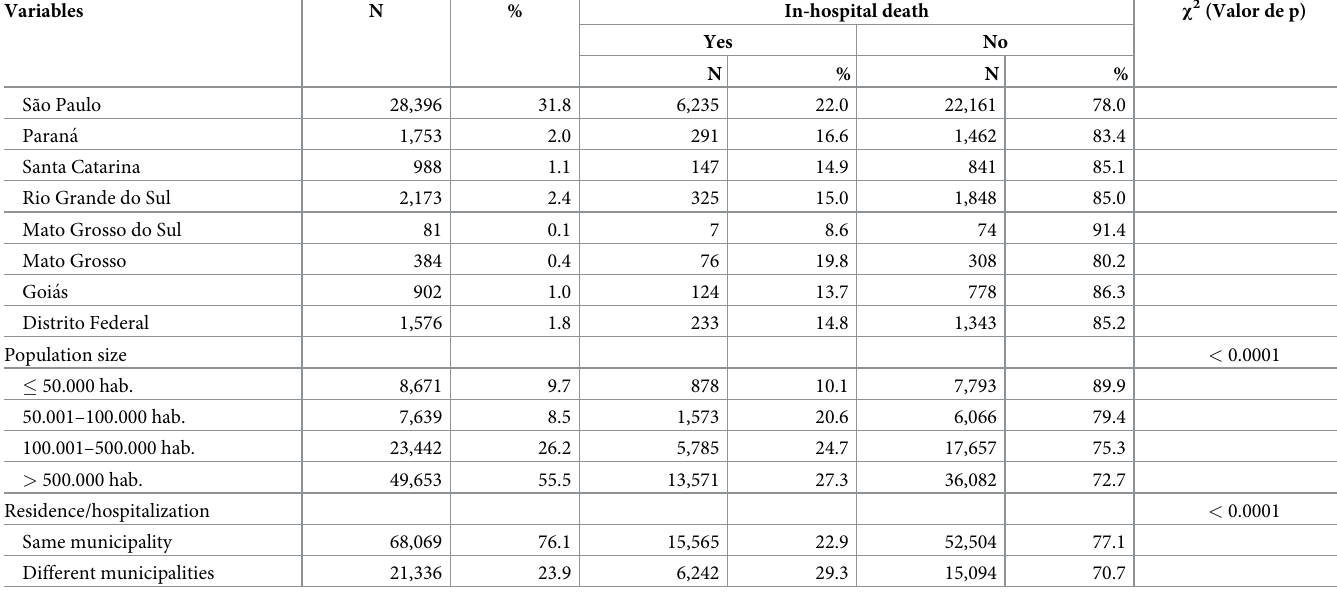
3.1% of the sample, and in this case, the bivariate analyses did not reveal any differences with respect to the occurrence of death. In Table 2, the percentage of hospitalizations of less than 24 hours or of one day (32.2%), as well as the high mortality of this category (11.8%), are salient statistics. Approximately two thirds of the total hospitalizations lasted up to 7 days (29.1%), between 8 and 22 days (3.4%) and 23 days or more (3.4%). Based on the bivariate analyses, there appears to be a greater con- centration of deaths in the extreme categories of LOS, with a lower occurrence of deaths (20.0%) among those with LOS between 2 and 7 days. The proportion of deaths among those who used the ICU was high (55.7%) compared to those who did not (15.3%). It is worth highlighting the difference between the LOS of those who did not die and those who died during hospitalization. In the first group, the average LOS was 6.7 ( ± 6.2) days, and the median was 5 days. Among the patients who died, the average LOS was 7.6 ( ± 7.2) days, and the median was 6 days. Table 3 shows that most hospitalizations for COVID-19 occurred in municipal public hos- pitals (42%), followed by state public hospitals (32.1%) and philanthropic hospitals (20.2%). The share of private hospitals contracted by SUS was 4.6%, while that of federal hospitals was